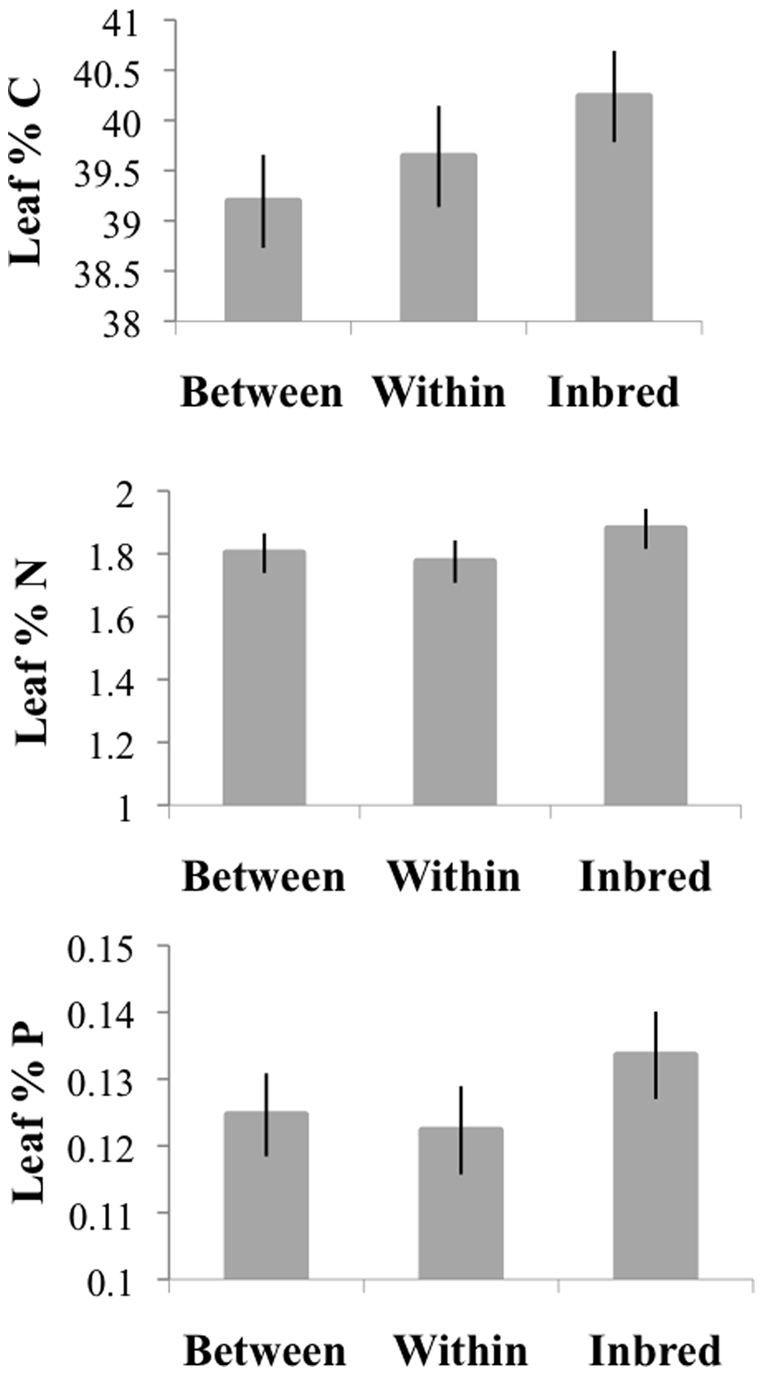
Least square means of %C, %N, and %P in leaves for each genotypic class (+/−1SE).Means are based on the univariate models presented in Table 1 and Table S1. Genotypic classes are made up of progeny from crosses between remnants “B”, within remnants “W”, and between sibs “I”. Light bars are June values and dark bars are August values. In the case of variables natural log (ln) transformed for analysis, we show back transformed values of predictions on the ln scale obtained from the models. Ln values +/−1SE were back transformed to give asymmetrical upper and lower error bounds.